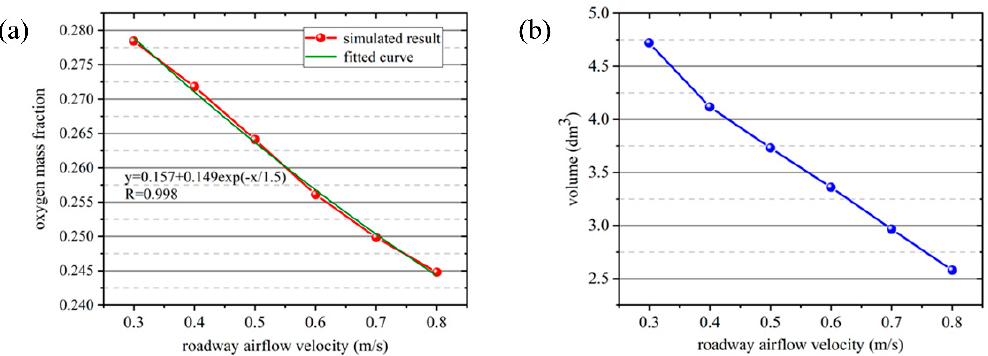
Figure 13. ( a ) Fitted curve of oxygen mass fraction of the air inhaled by human at different tunnel airflow velocities; ( b ) Volumetric distribution of regions with oxygen mass fraction up to 24.35% at different tunnel airflow velocities.